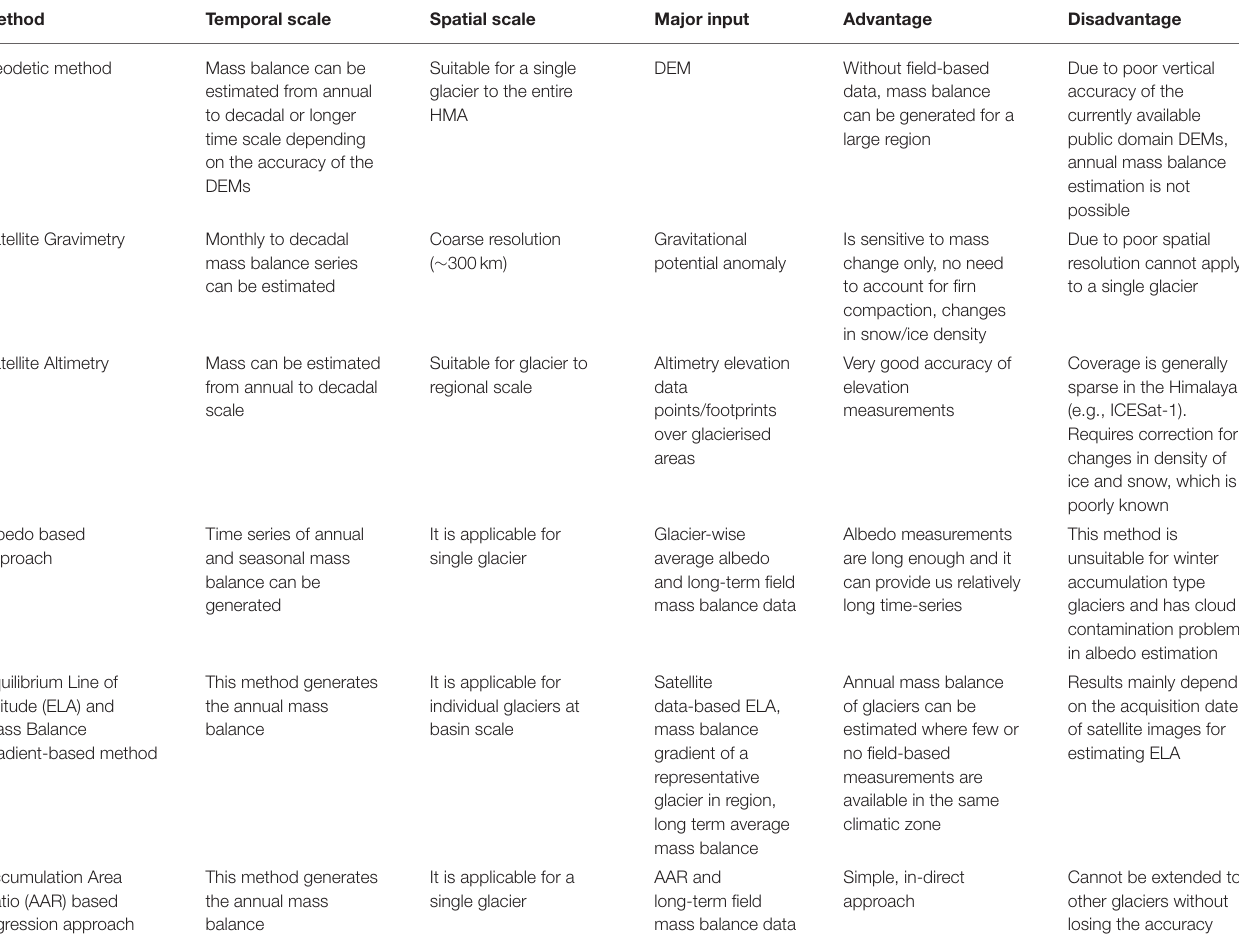
TABLE 2 | Comparison of different remote sensing-based methods for mass balance